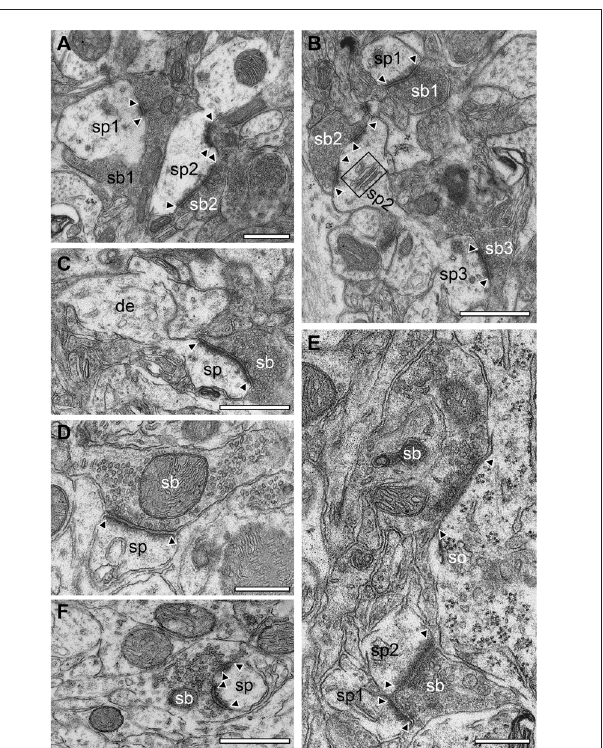
FIGURE 11 | Synapses in different layers of the adult WT mouse neocortex. (A) EM micrograph of two synaptic complexes between two spines (sp1, sp2) of different shape and size and two synaptic boutons (sb1, sb2) in L2/3. Note that sb1 was comparably large in both size and its pool of synaptic vesicles but had only a single small active zone whereas sb2 had two active zones located at the spine head and neck and a smaller pool of synaptic vesicles. (B) Two opposing spines (sp2, sp3) located on the same dendrite with two synaptic boutons (sb2, sb3) in L2/3. Sp3 had only a single active zone whereas sp2 contained two active zones and a prominent spine apparatus (framed area). In the surrounding neuropil another synaptic complex (sp1, sb1) with a single, but large active zone covering almost the entire length of the synaptic apposition zone is shown. (C) Synaptic bouton (sb) terminating on a typical mushroom-shaped spine (sp) emerging from a small caliber dendrite (de) with a large non-perforated active zone in L4. (D) En passent putative GABAergic synaptic bouton (sb) identified by the small ovoid-shaped synaptic vesicles and the narrow PSD of the active zone terminating on a spine (sp) in L4. (E) GABAergic synaptic bouton (sb) terminating on the soma (so) of a putative pyramidal neuron in L5. Note also the synaptic bouton (sb) terminating on two adjacent spines (sp1, sp2). (F) Synaptic bouton (sb) with two active zones completely ensheathing a dendritic spine head (sp) located in L6. Scale bar in (A–F) 0.5 µ m. In all images, active zones are marked by